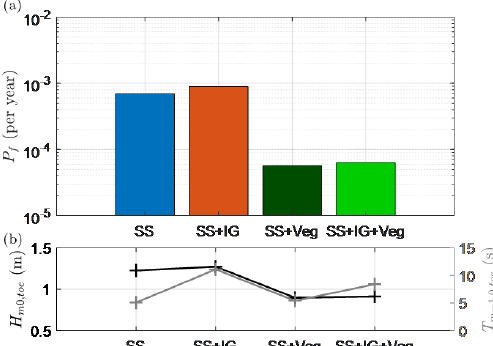
Figure 9. Relationship between (a) annual failure probabilities at Uithuizerwad for the scenarios considered and (b) physical pa- rameters for a proxy storm with an exceedance probability of 1 / 3000 per year and a still water level of 5.26m + NAP. Crest level of 6m + NAP and dike slope of 1 : 7 are considered. Note that the influence of vegetation may be overestimated (Sect. 4.4).